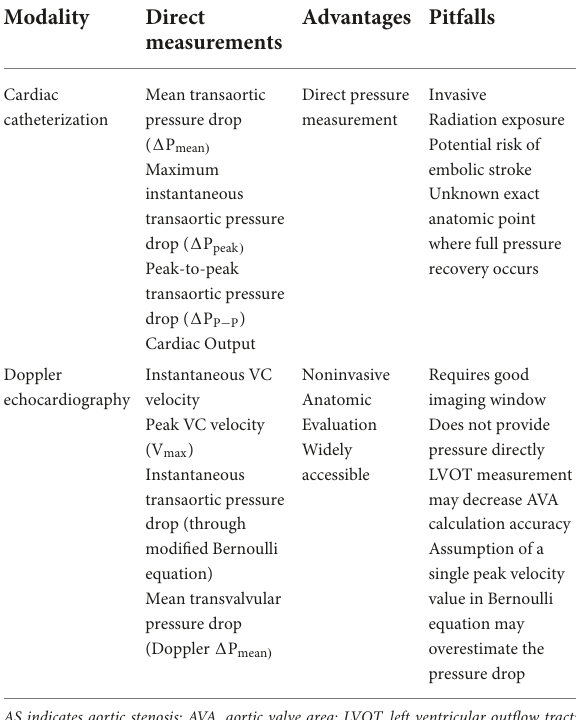
TABLE 1 Comparison of cardiac catheterization and Doppler echocardiography for AS evaluation.